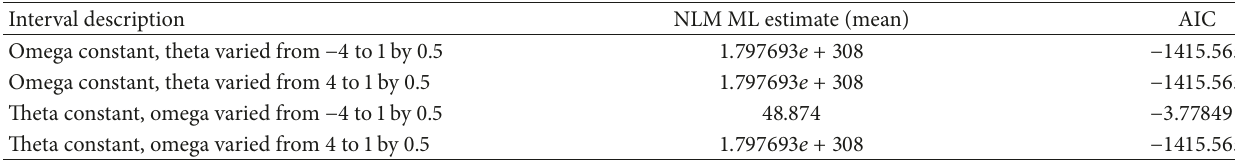
Table 6: Summary of results for lambda = 0.8, 𝑛 = 10 𝑖 , 𝑖 = 3 .